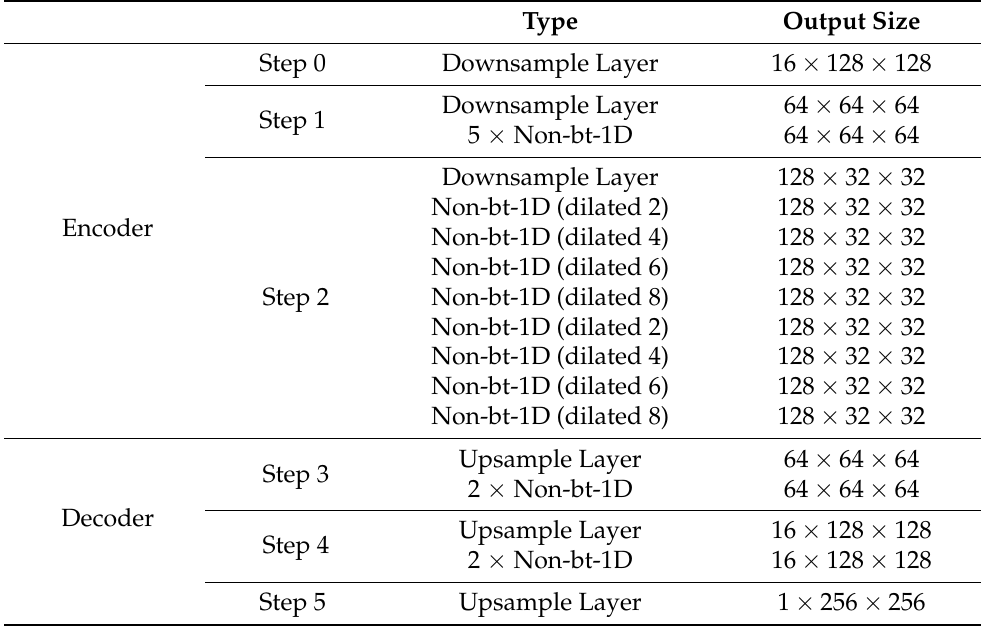
Table A2. Details of imaging-path